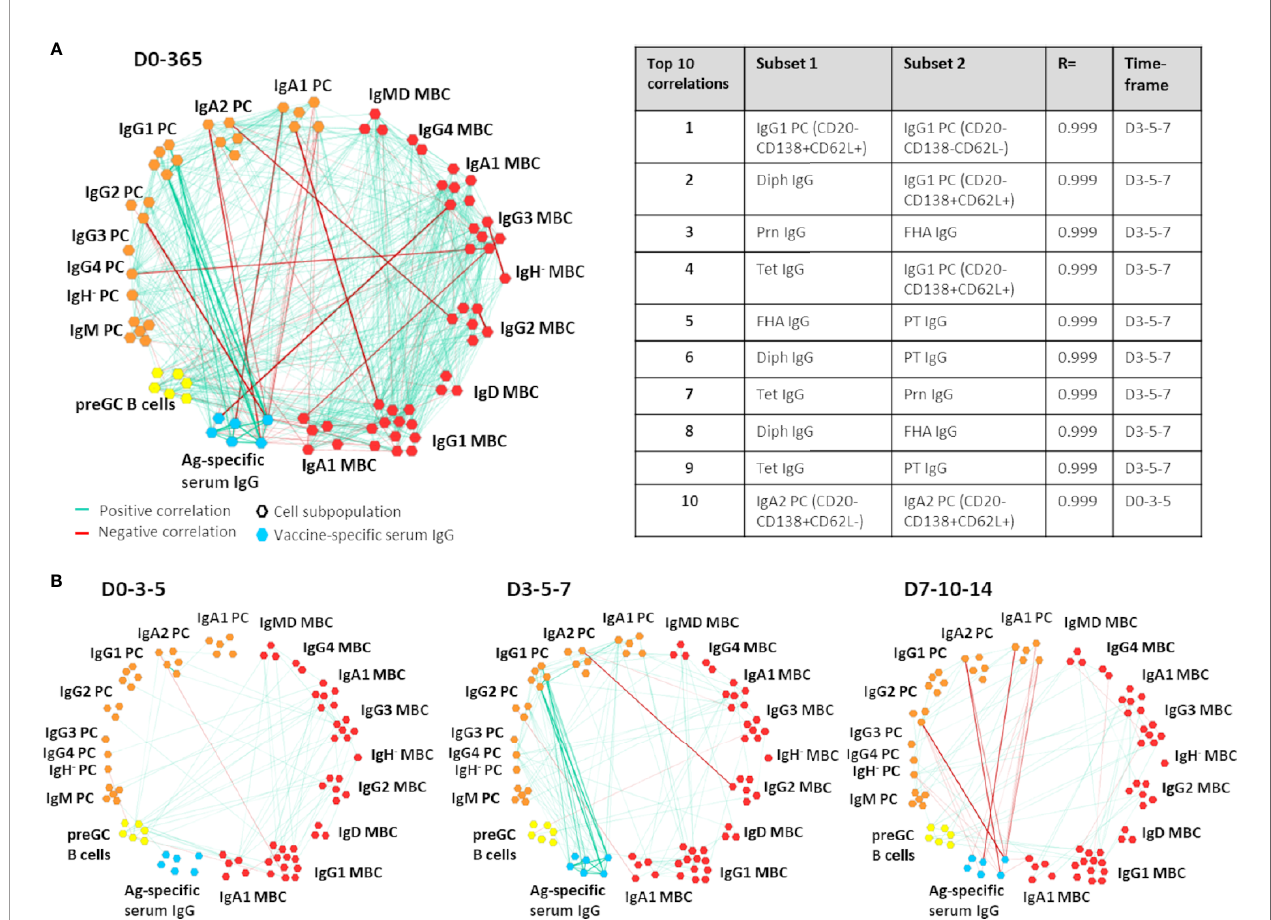
FIGURE 1 | Example of Cytoscape network analysis between B-cell subsets and/or antigen-speci fi c serum IgGs. In this example, correlations between and within the B-cell compartment and Ag-speci fi c serum IgGs are shown. All positive and negative correlations with an R>0.90 or R<-0.90 over 3 sequential time points and present in at least 8/10 donors were visualized. Only subsets that had at least 1 correlation were shown in the network. For ease of interpretation, subset names have been removed and group names have been added. Of note, the most informative correlation networks found in this study were visualized in the Gephi software and are added as supplemental movies to this manuscript. MBC, Memory B cells (red); PC, plasma cells (orange); preGC B cells, pre-germinal center B cells (yellow); Ag-speci fi c serum IgG, antigen-speci fi c serum IgG (blue); D, Days after vaccination. (A) All correlations found within and between the B-cell compartment and Ag- speci fi c serum IgGs at all time points. The table presents an overview of the 10 strongest correlations of the visualized network. (B) The most relevant correlations visualized per